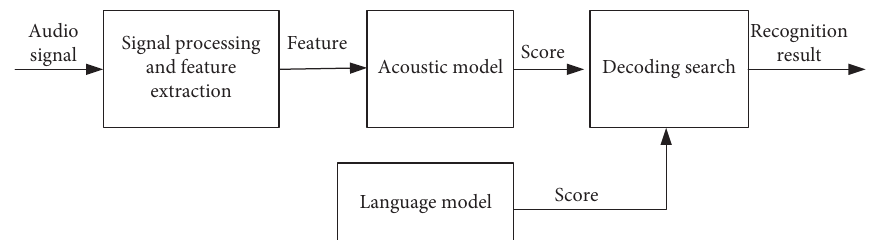
Figure 1: Speech recognition system.